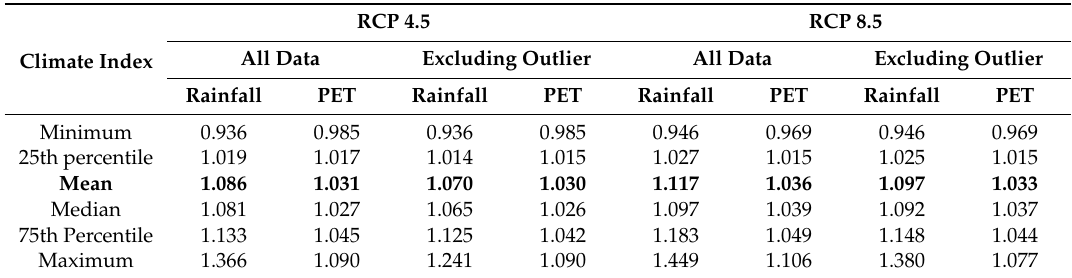
Table 3. Summary of scaling factors for 28 model projections for the six GCM grids in the northwest region of Bangladesh.